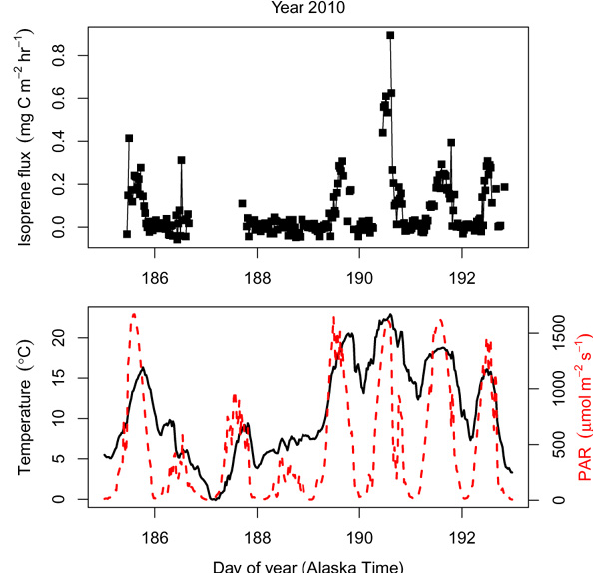
Fig. 4. Ecosystem-level fluxes of isoprene (top panel) and tempera- ture (black, solid line) and photosynthetically active radiation (red, dashed line) for 2010 (bottom